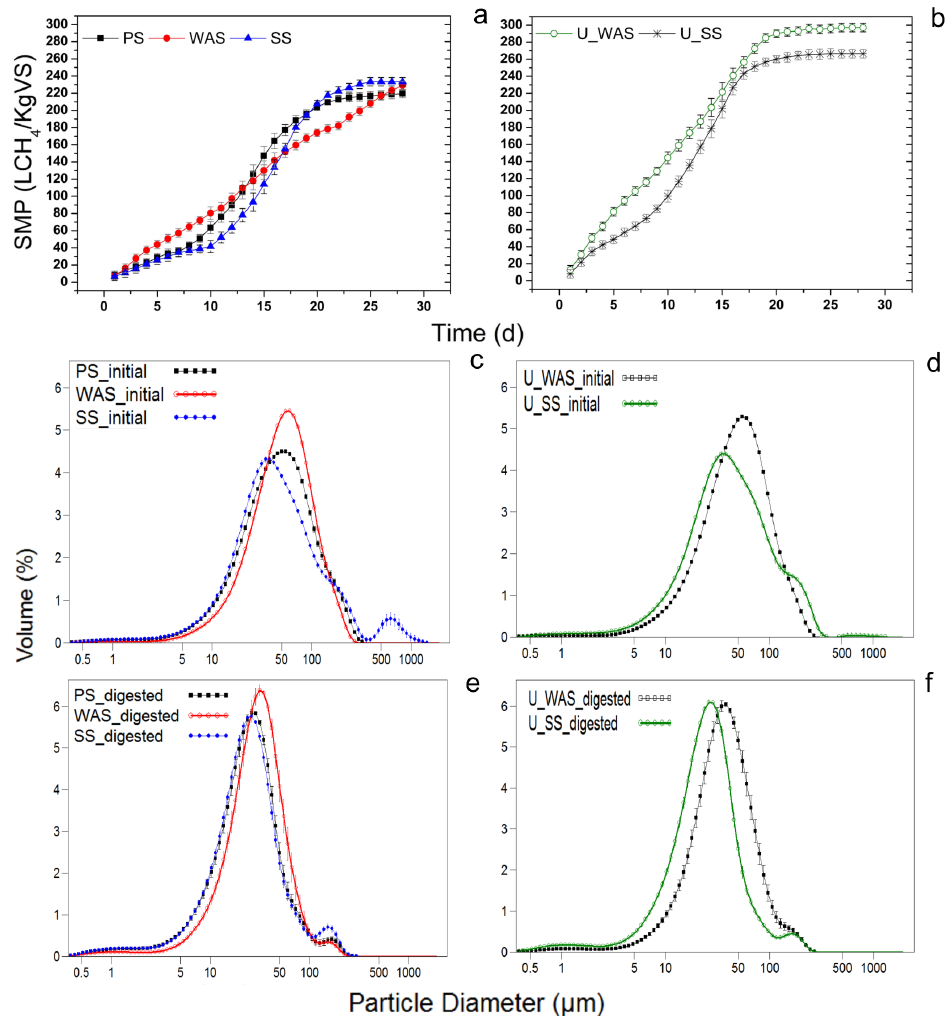
Figure 1. ( a , b ) Specific methane production (SMP) obtained from batch tests for samples: primary sludge (PS), waste activated sludge (WAS), sewage sludge (SS), and ultrasound-pretreated samples U_WAS, U_SS; ( c – f ) Particle size distribution (PSD) of samples taken prior to (initial) and after (digested) batch digestion